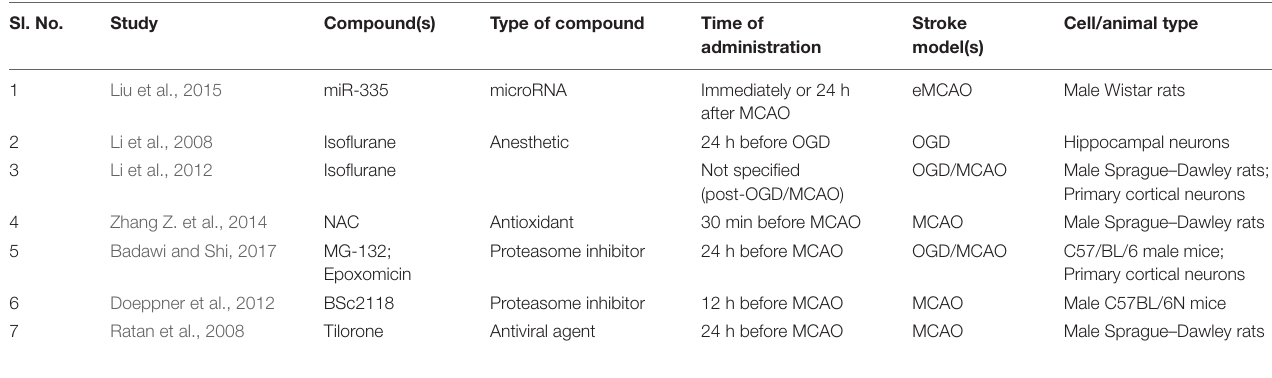
TABLE 1 | Details about the studies that used non-PHD HIF-1 α stabilizers as hypoxia-mimetic agents. Sl.